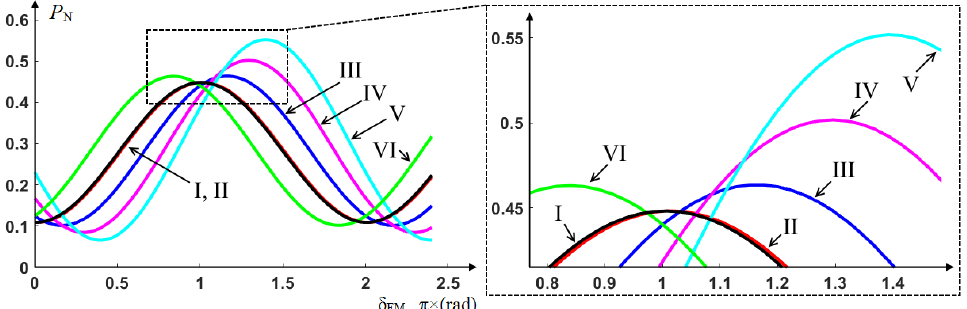
Figure 2. Normalized power at the photodetector P N = P outCW / P inCW for a ring resonator radius of 10 mm, K c = 0.05, and P = 0.025, and rotation speeds Ω : 0 rad/s — curve I; 20 rad/s, curve II; 400 rad/s, curve III; 800 rad/s — curve IV; 1200 rad/s — curve V; – 400 rad/s — curve VI.